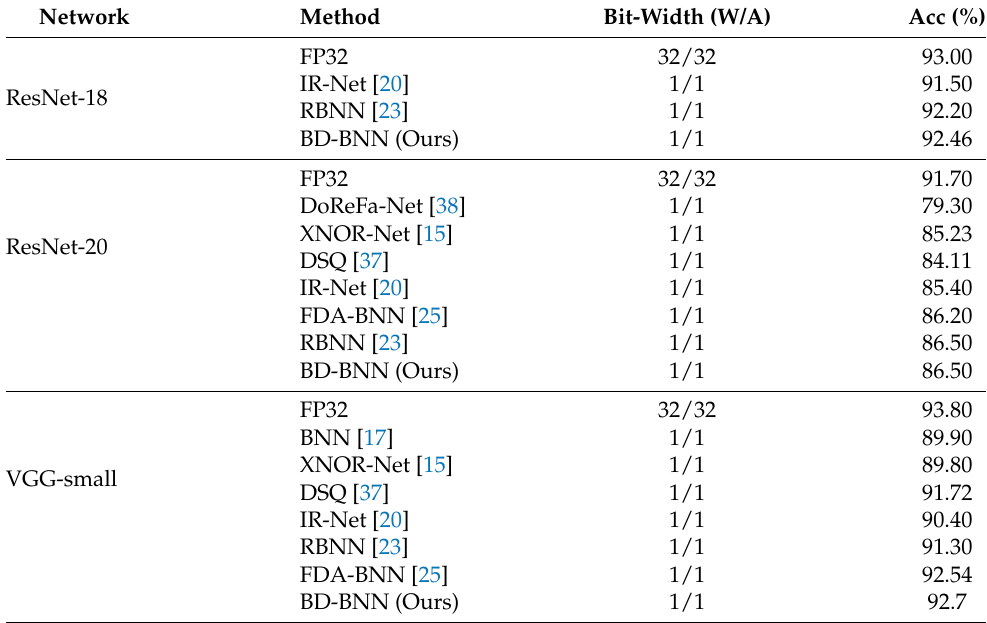
Table 1. Performance comparison with state-of-the-art methods on CIFAR-10. W/A denotes the bit length of weights and